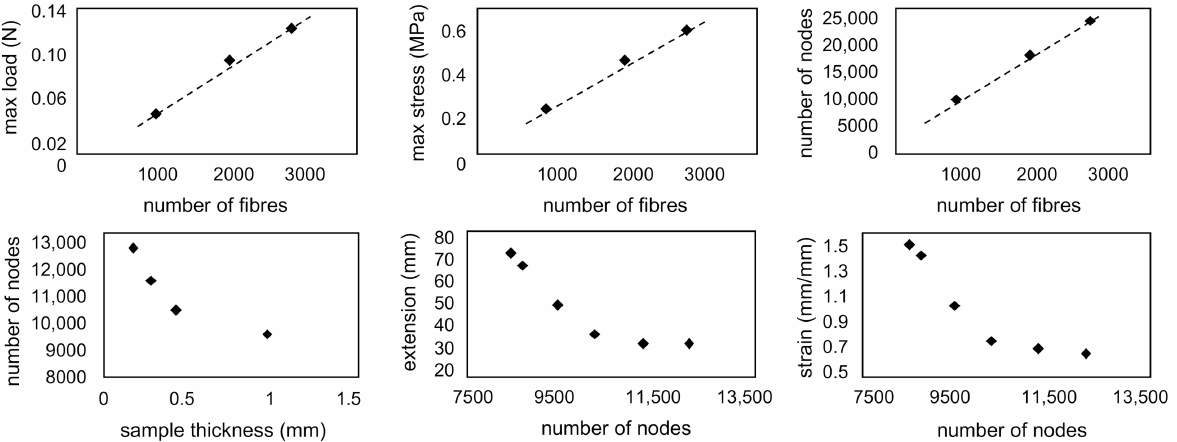
Figure 3. Dependencies of parameters observed in the model showing ( top ) the influence of the number of fibres on the maximum load and stress and the number of nodes, ( bottom ) the sample thickness on the number of nodes, and the number of nodes on extension and strain in the